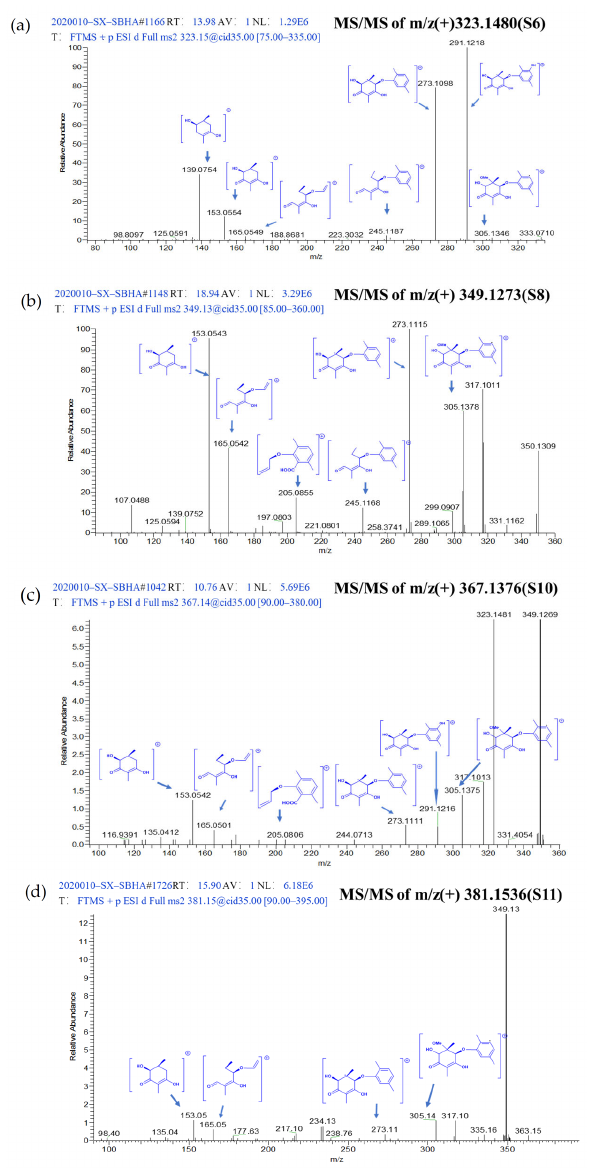
Figure 3. Annotated MS/MS spectrum of ( a ) m/z 323.1480 ( S6 ), ( b ) m/z 349.1273 ( S8 ), ( c ) m/z 367.1376 ( S10 ), d. m/z 381.1536 ( S11 ) acquired by LTQ ‐ Orbitrap ‐ XL in positive mode.